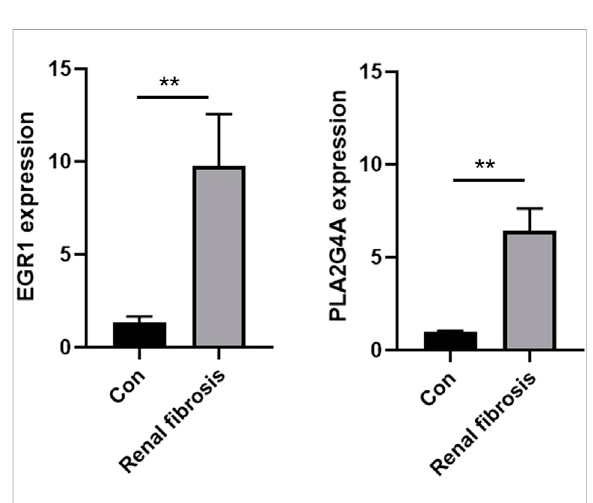
FIGURE 11 EGR1 and PLA2G4A mRNA expressions were analyzed by using the qRT-PCR assay in renal fi brosis and adjacent normal